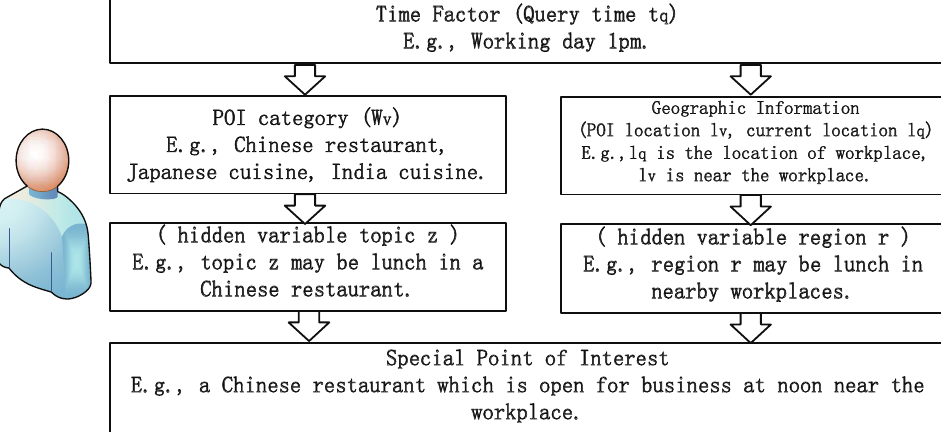
Figure 1. The decision-making process of a user to visit a